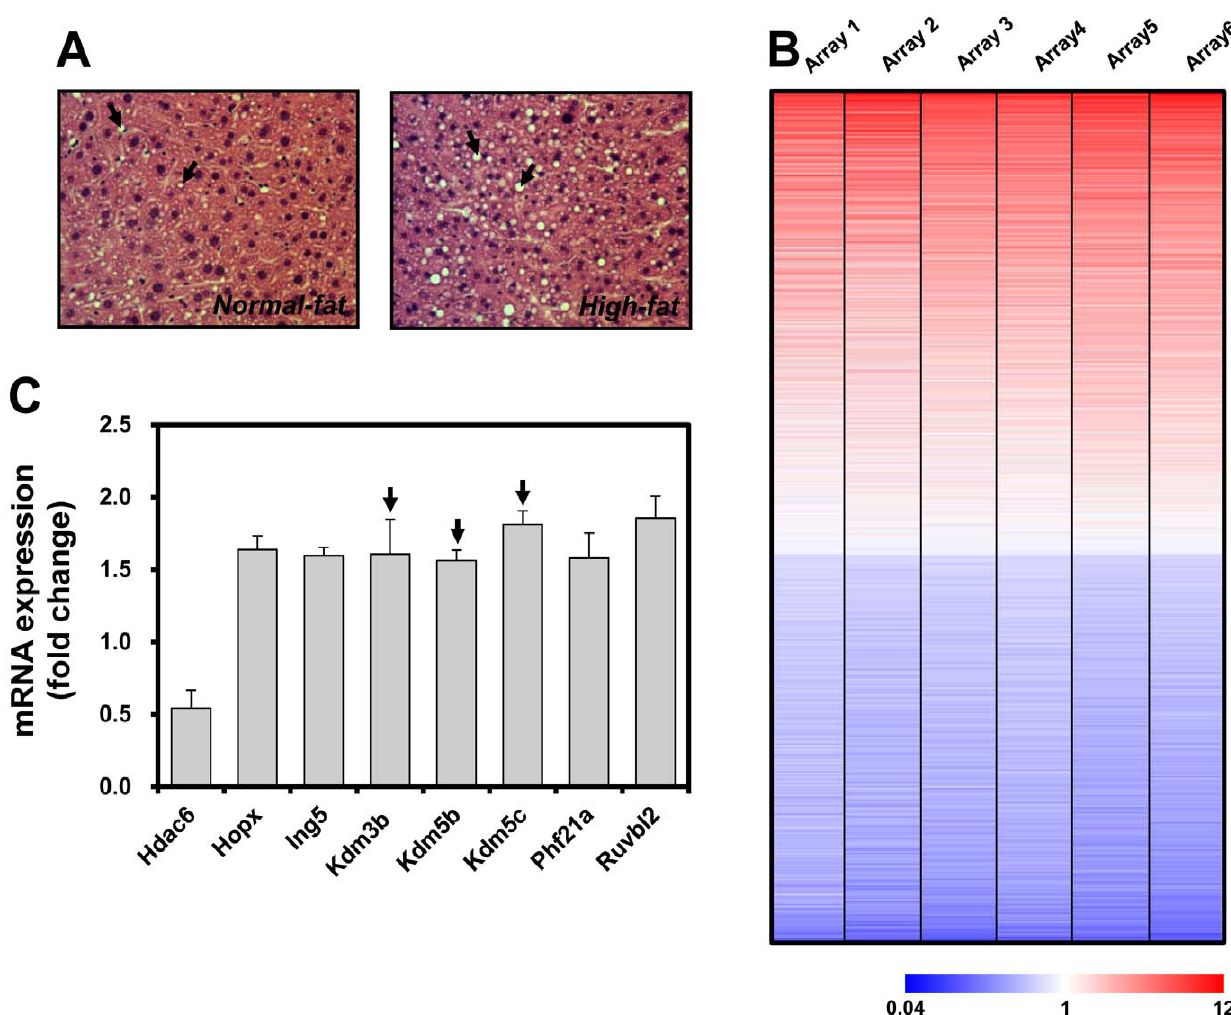
Figure 1. Transcriptome profile of the steatotic livers of high-fat diet-fed hAPOE2 mice determined by oligonucleotide microarray analysis. (A) H&E staining of the livers of normal diet- and high-fat diet-fed hAPOE2 mice (original magnification, 6 400). (B) Heat map of the transcriptome profile of the steatotic livers of high-fat diet-fed hAPOE2 mice. Columns represent individual arrays and rows indicate gene expression profiles. Red, blue, and white indicate upregulated, downregulated, and unaltered genes, respectively ( p , 0.05, n=6). (C) mRNA expression of genes encoding epigenetic modifiers in the steatotic livers of high-fat diet-fed hAPOE2 mice ( p , 0.05).